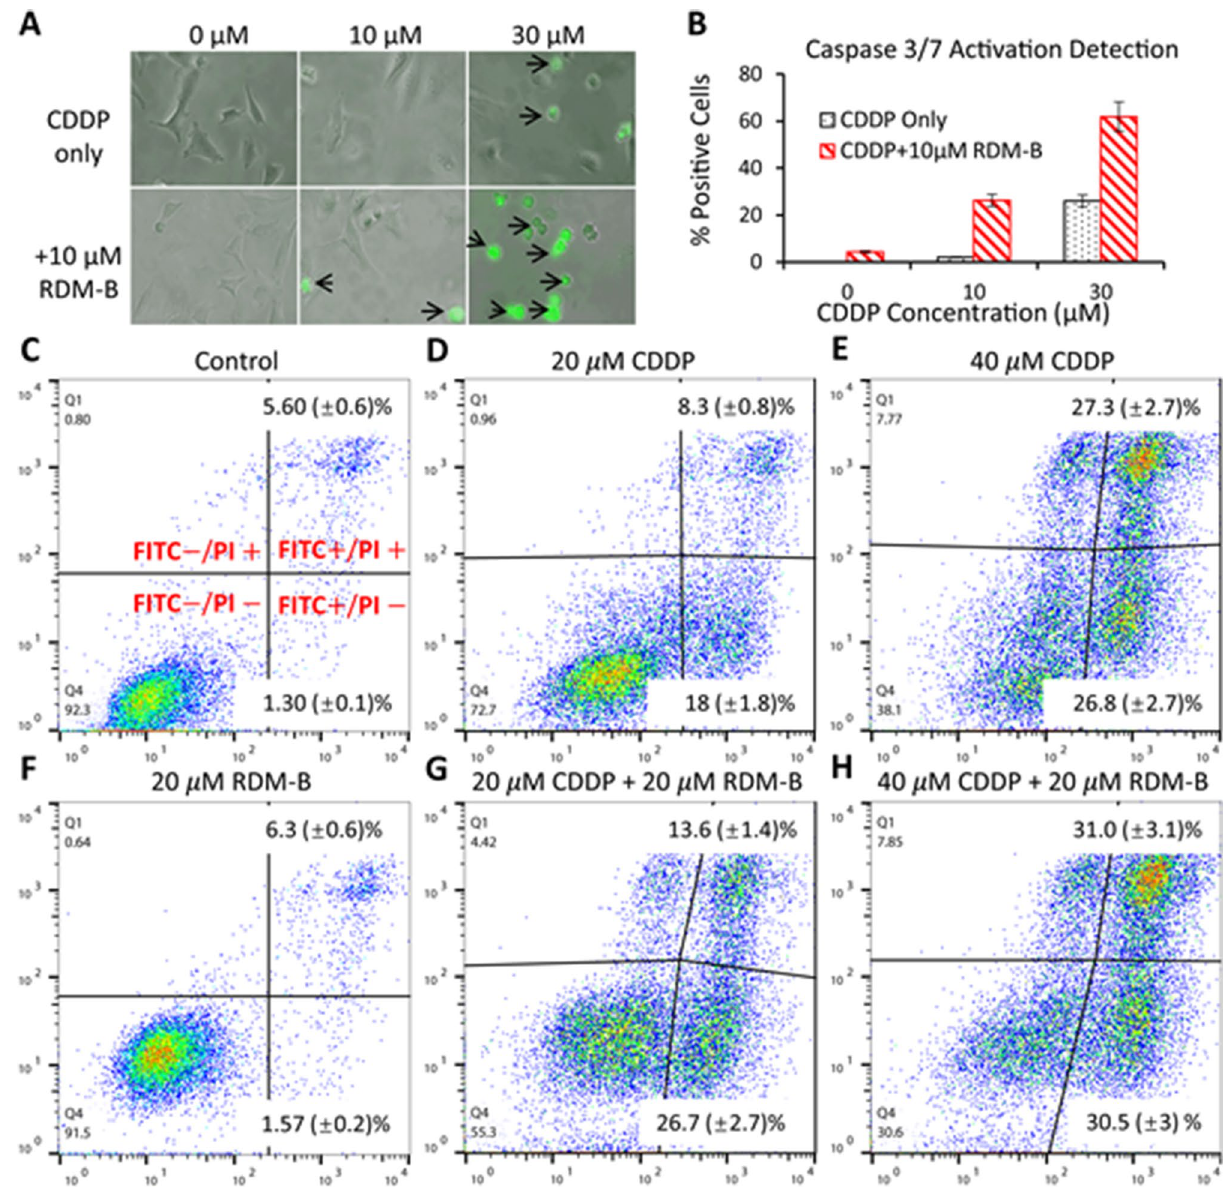
Figure 4. In vitro apoptosis detection in cervical cancer HeLa cells. ( A ) Representative pictures (black arrows indicating morphological changes) of HeLa cells treated with 10 μM and 30 μM CDDP with/without the combination of 10 μM RDM-B (BV10) for 12 h and then incubated with the CellEvent Caspase-3/7 Green Detection Reagent and analyzed using fluorescence microscopy. ( B ) Percentages of activated caspases 3/7. ( C )– ( H ) Early/late apoptosis measurements of HeLa cells treated with 20 μM and 40 μM CDDP with/without the combination of 20 μM BV10 for 18 h using an Annexin V-FITC Apoptosis Detection Kit, where the cells were double stained with Annexin-V-FITC and PI. Quantitative analyses of the cell images in A and flow cytometry data in ( C )–( H ) were performed using an ImageJ software (https ://image j.nih.gov/ij/) and a FlowJo software (https ://www.flowj o.com/solut ions/flowj o), cancer A549 model, and 2.5 mg/kg × 4 in the (highly) cisplatin-resistant ovarian cancer NIH:OVCAR-3 model; RDM-B (BV10) (alone or in the combination) was administered at 8.0 mg/kg per treatment. The treatments were given every other day. For the three xenograft tumor models, tumor growth curves are shown in Fig. 5, whereas measured volumes of tumours at day 1 (pre-treatment), 5, 10, and 20 of the treatments are given in Table 1. As seen from Fig. 5A and Table 1, the 8 mg/kg × 3 BV10 treatment only weakly inhibited the tumor growth in the lung cancer model, whereas the 2.5 mg/kg × 3 CDDP treatment induced mild tumor shrinkage (from the volume of 200 mm 3 to the lowest of ~ 187 mm 3 ) during the treatment period (day 1–5) and it took 3 days only to regrow back to the pre-treatment volume. In comparison, the (2.5 mg/kg CDDP + 8 mg/kg BV10) × 3 combination treatment induced a much more significant tumor shrinkage (to the lowest volume of ~ 154 mm 3 ).